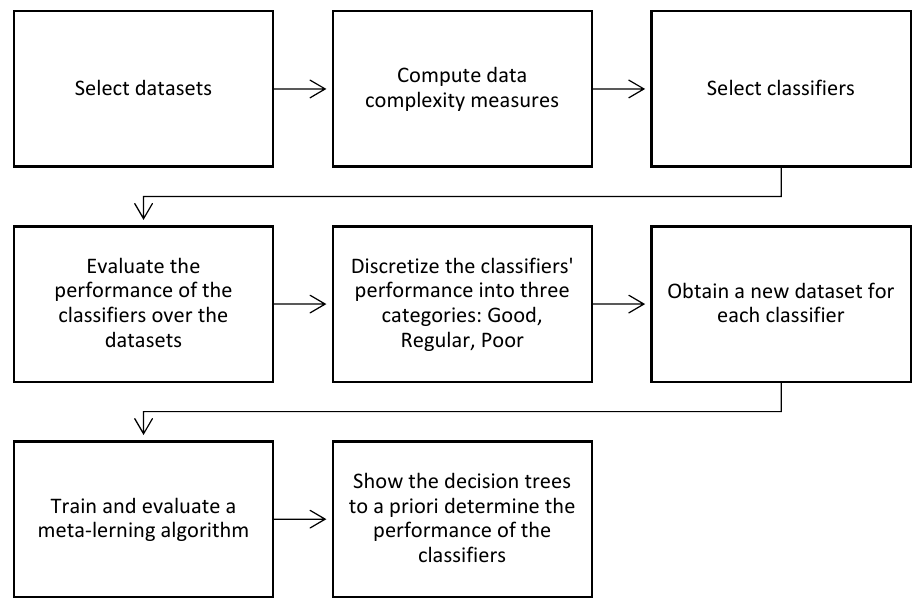
Figure 1. Schematic diagram of the experimental setup.